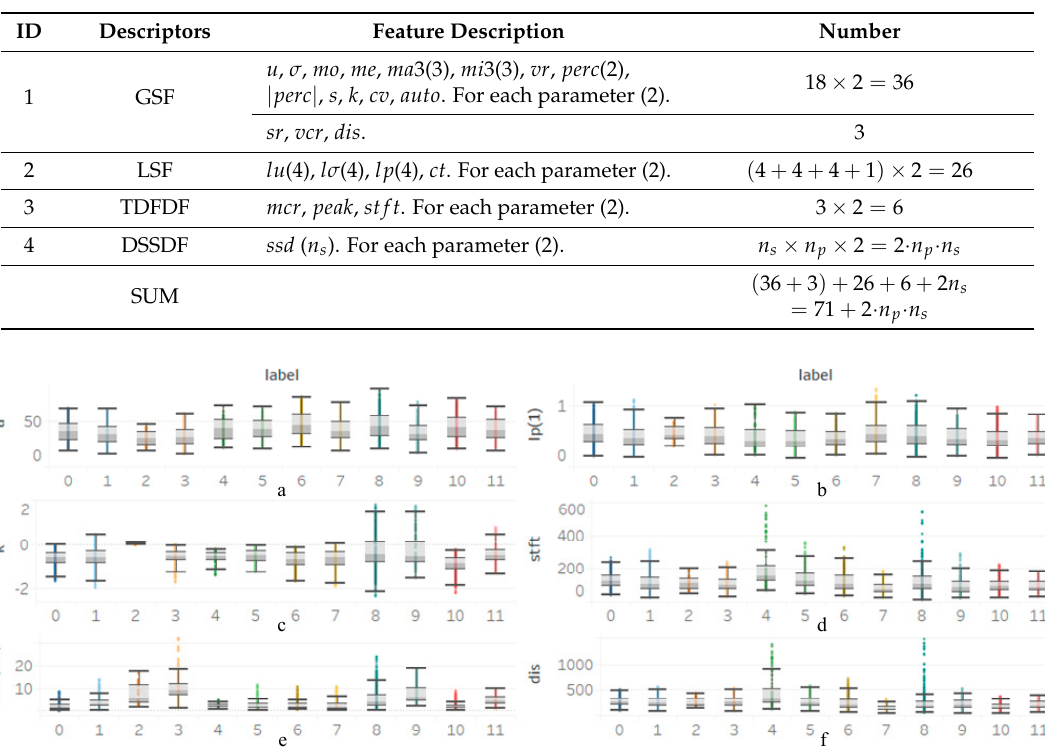
Table 2. Feature Summary.